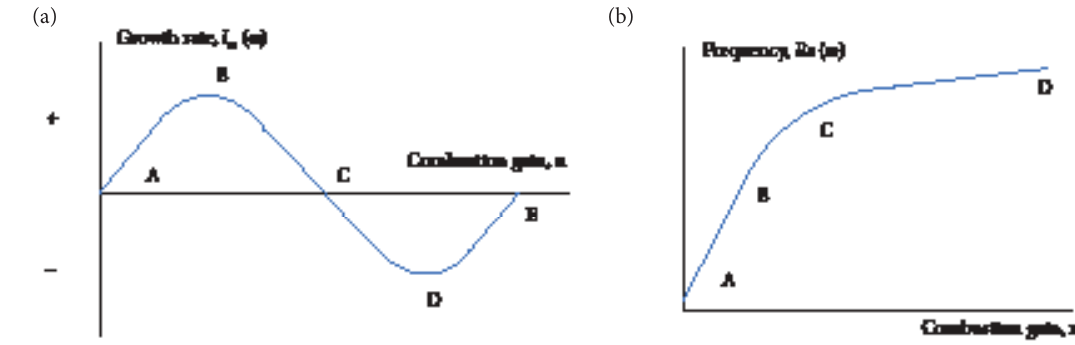
Figure 2. Schematic mode diagram showing (a) growth rate and (b) frequency (combustion delay and geometric parameters constant).